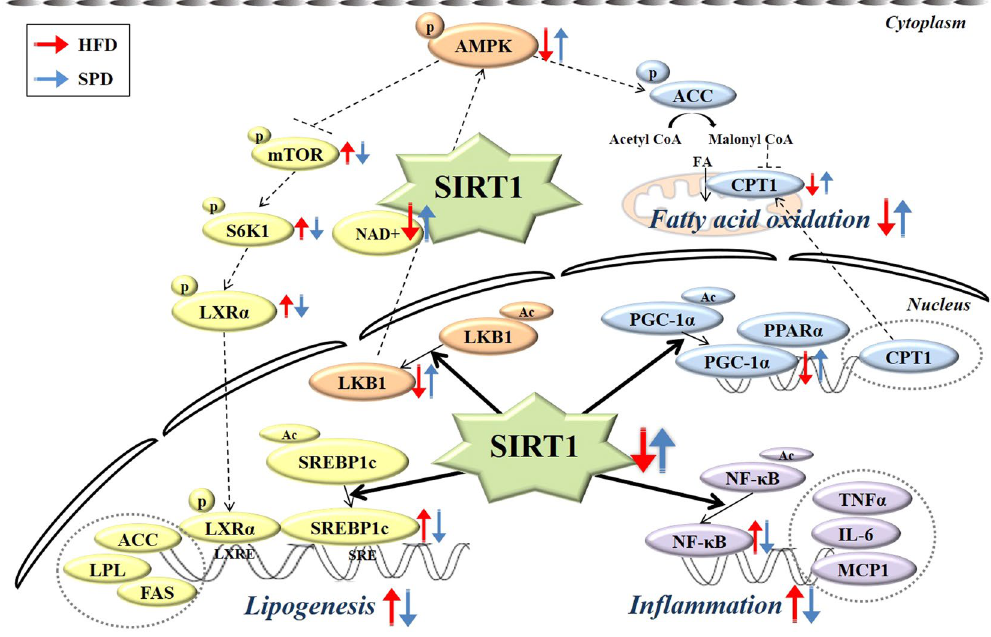
Figure 6. Proposed mechanism for the protective effects of scopolin against hepatic steatosis in mice: Key lipid regulatory pathways influenced by SIRT1 deacetylase activity. The crosstalk between various signaling pathways allows SIRT1 to function as a potent regulator of lipid homeostasis in liver tissues. As depicted, SIRT1 activation in response to scopolin can lead to increased deacetylation of SREBP1c protein in the liver with subsequent downregulation of lipogenic genes (LXR α , ACC, LPL, and FAS) along with increased deacetylation of PGC-1 α protein with upregulation of genes involved in fatty acid oxidation (PPAR α and CPT1). Alternatively or synergistically, scopolin-induced SIRT1 activation can lead to the deacetylation of LKB1 protein in the liver with consequent upregulation of p-AMPK and p-ACC, and downregulation of p-mTOR and p-S6K1, which would lead to increased fatty acid oxidation and decreased lipogenesis, respectively. SIRT1 activation can also lead to the deacetylation of NF- κ B, a proinflammatory master switch with subsequent downregulation of MCP- 1, TNF α , and